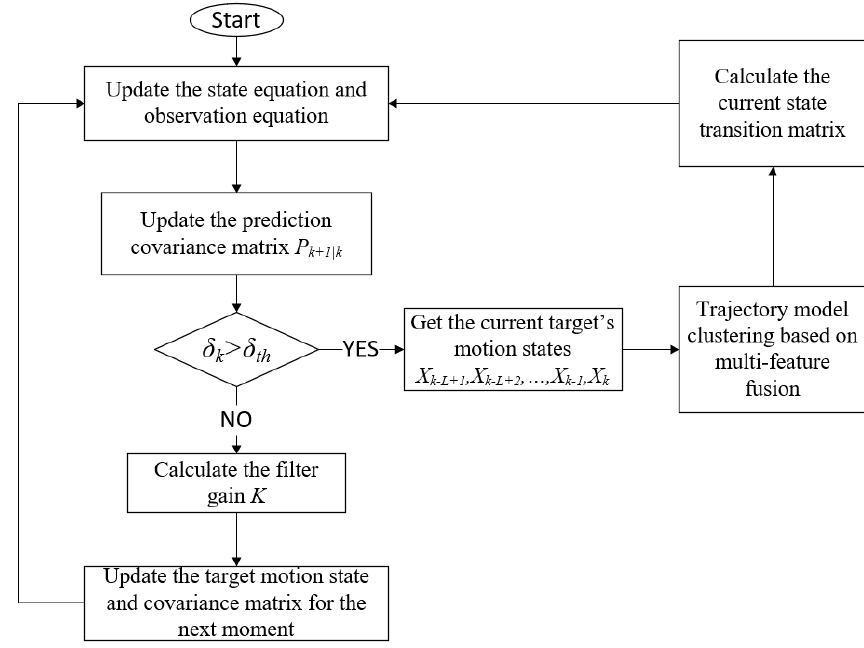
Figure 1. Flowchart of the STMU − EKF algorithm.